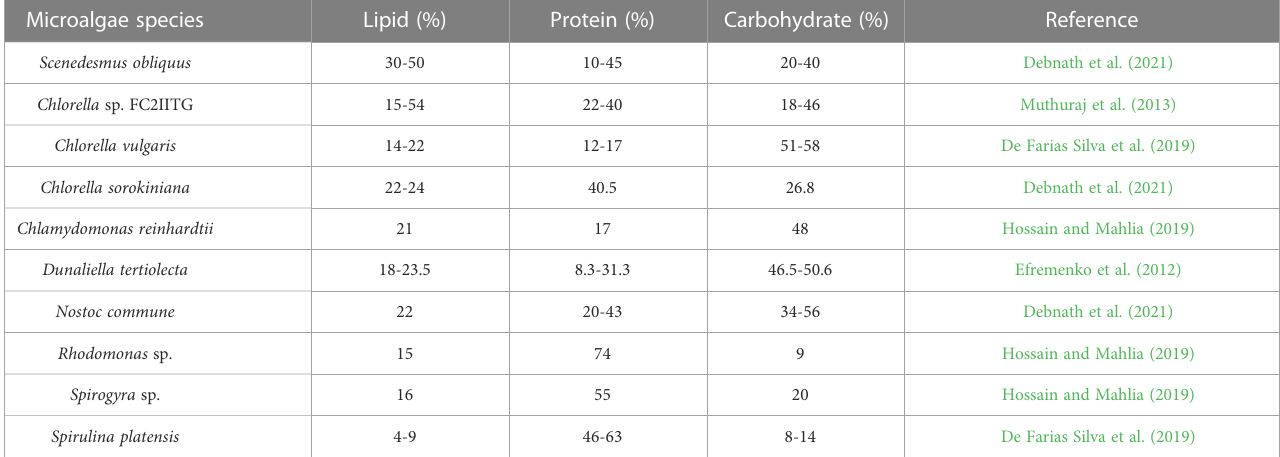
TABLE 1 Biochemical composition of different microalgae species. Microalgae